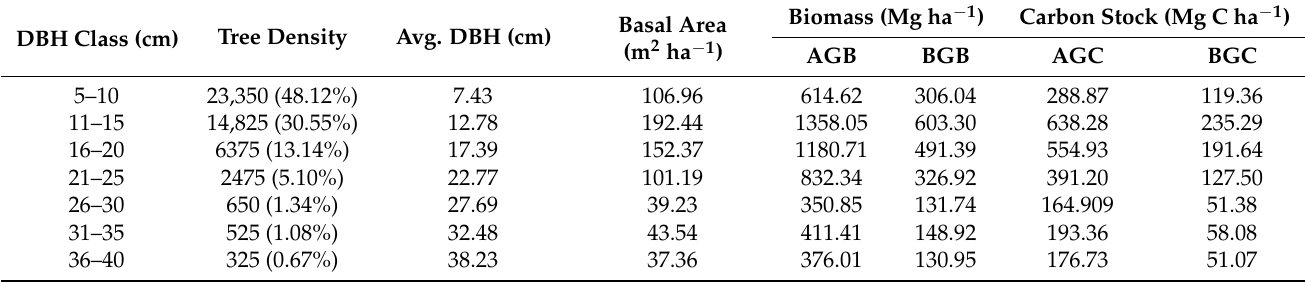
Table A2. Distribution of stand structures, biomass, and carbon storage according to diameter